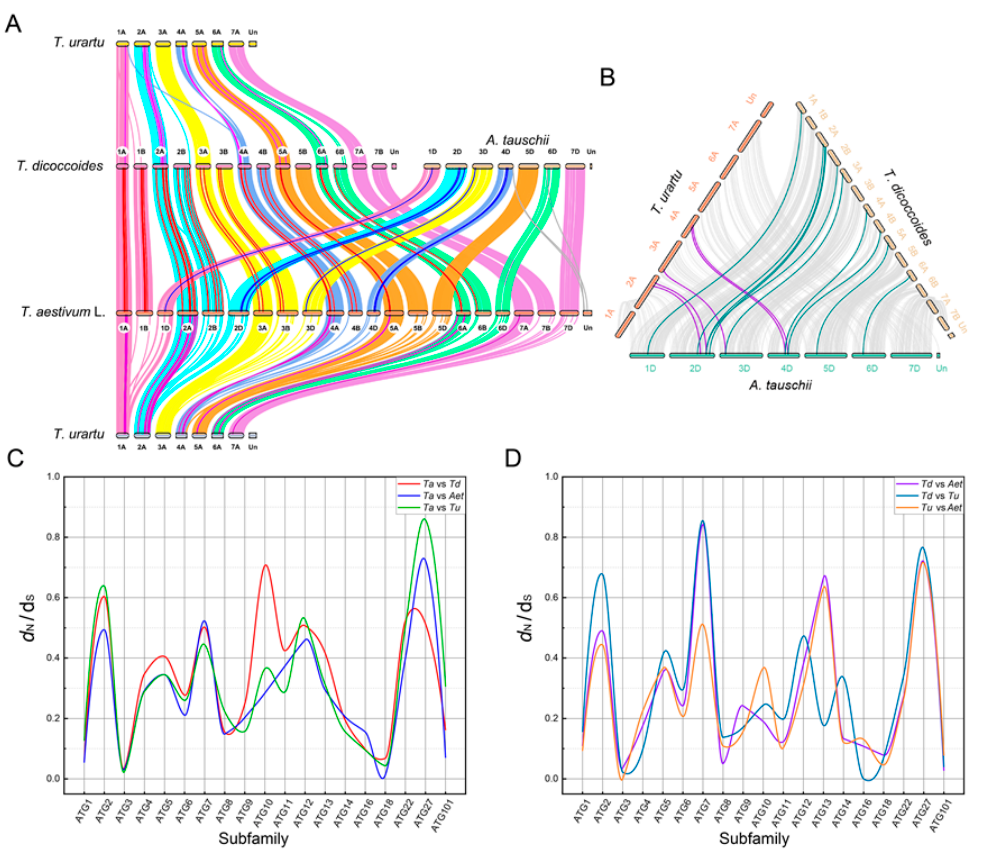
Figure 4. Collinearity relation of four Triticeae species and synonymous ( dS ) to nonsynonymous ( dN ) substitution ratio among ATG subfamilies. ( A ) Collinearity relations of ATGs between every two species are shown in different colors. ( B ) The collinearity relationship among A. tauschii to T. urartu and wild emmer. ( C , D ) The dN/dS ratio distribution of wheat and its three diploid and tetraploid progenitors among different subfamilies.